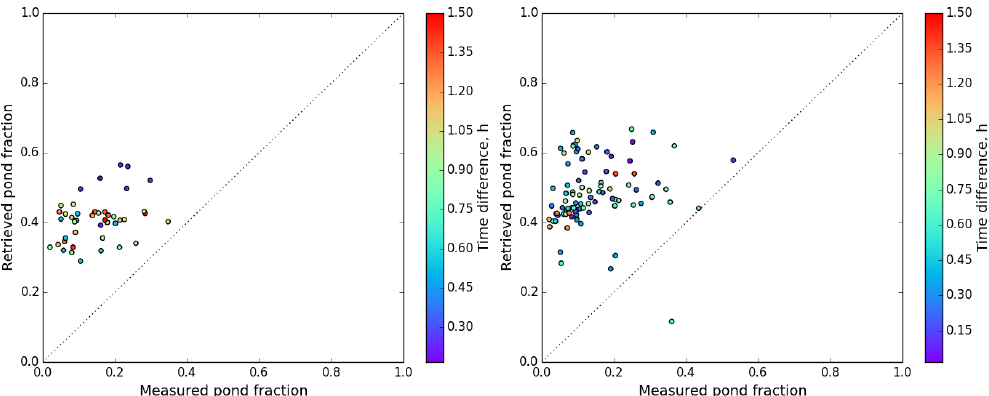
Figure 14. Retrieved melt pond fractions from satellite- vs. airborne-classified MPs over FYI, possible drift, 26 May 2008 (left panel), N = 44, R 2 = 0.13, RMS = 0.274, and 4 June 2008 (right panel, the flight track is shown in Fig. 9, bottom panel), Beaufort Sea, N = 93, R 2 = 0.02. RMS = 0.361. Both cases feature brash ice with subpixel ice floes which are covered not with white ice, but with blue ice (sea ice without the scattering layer), which has spectral response similar to MPs within the VIS and IR spectral range.